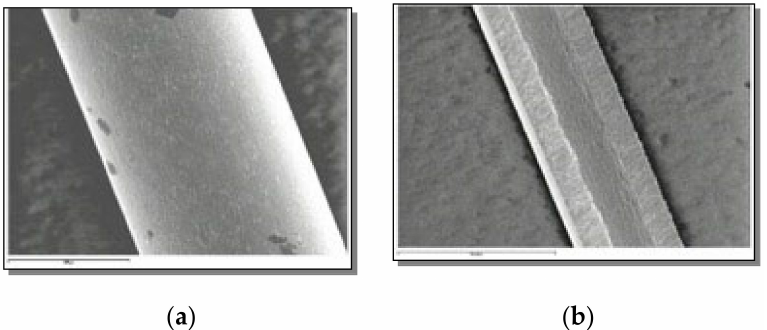
Figure 5. Images of hypotube #8(ref): ( a ) exterior surface (scale = 200 µ m) and ( b ) interior surface (scale = 500 µ m).